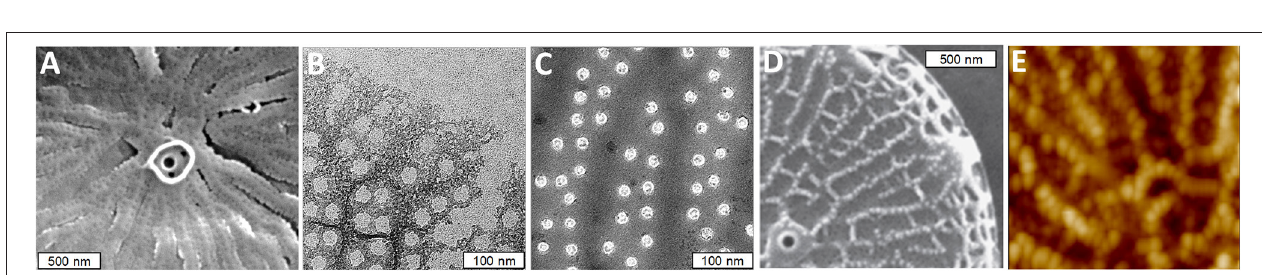
FIGURE 2 | Formation of the T. pseudonana valve. (A) SEM of the base layer. (B) Schematic of x/y axis expansion during base layer formation. (C) Intermediate stage of valve formation showing buildup of the rim, but lack of extensive silicification in the center. (D) Fully formed valve. (E) Cross section schematic of silica deposition in the distal z-axis direction with the lower image representing the initial base layer and the upper representing the fully silicified valve with the final rigid structure. From Hildebrand et al. (2006), reproduced with permission.